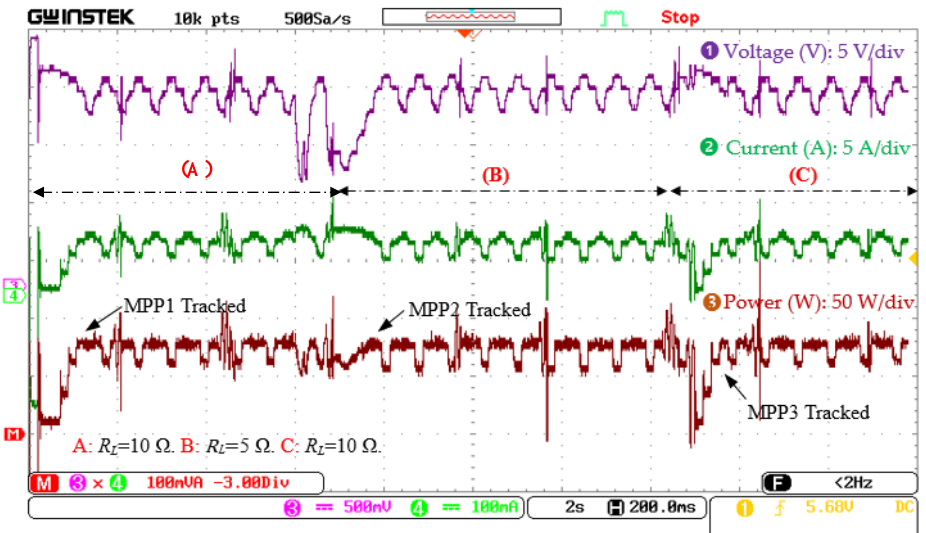
Figure 22. Experimental waveforms of the CSL-MPPT in the presence of the load disturbances.